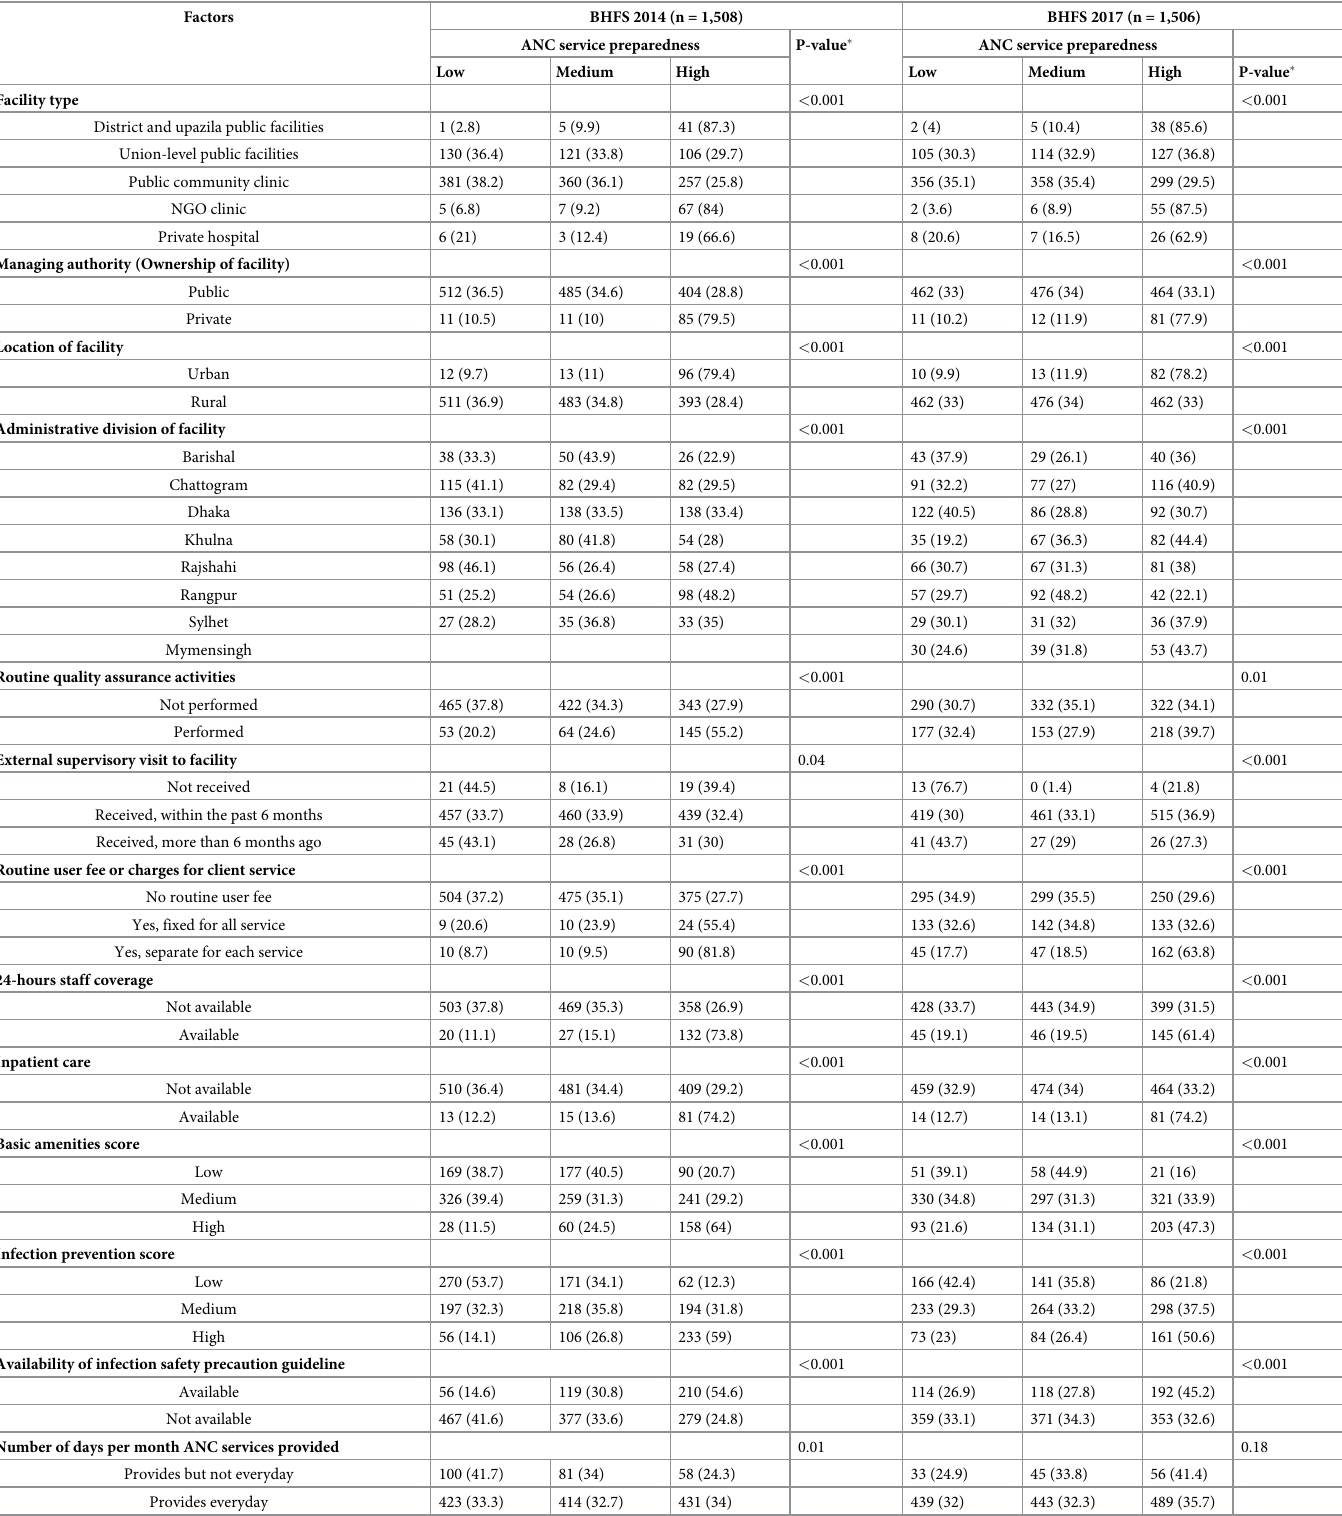
Table 3. Distribution of different factors and their associations with ANC service preparedness of Bangladeshi health care facilities by survey